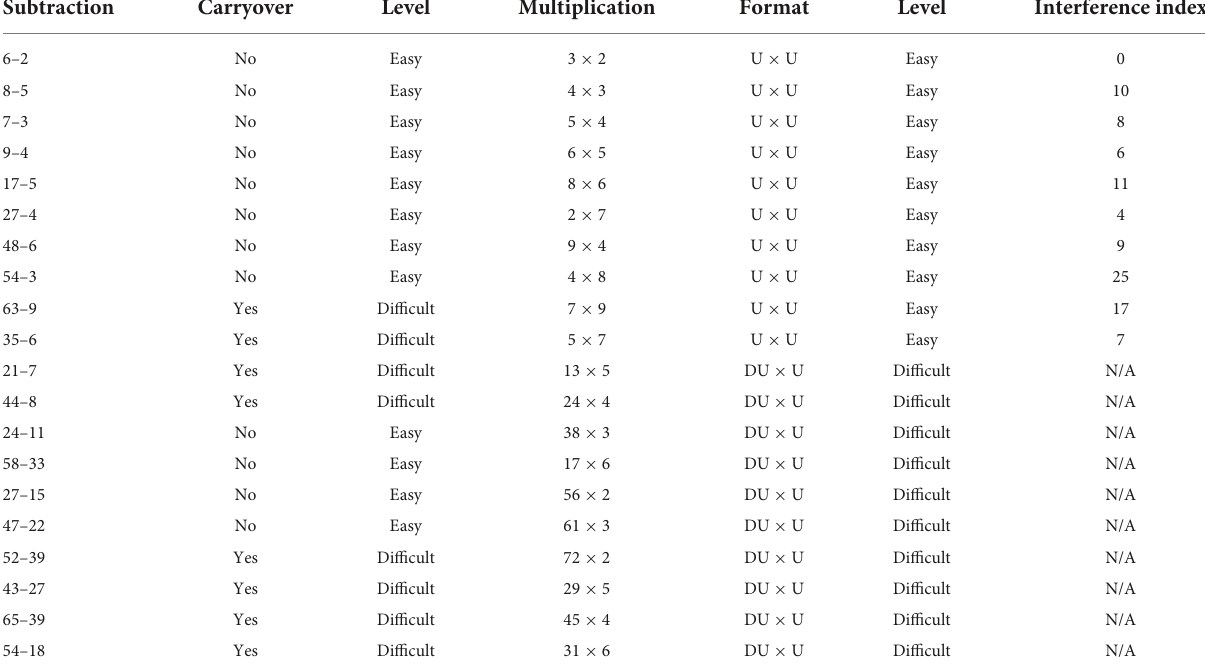
TABLE 2 Operations presented to the